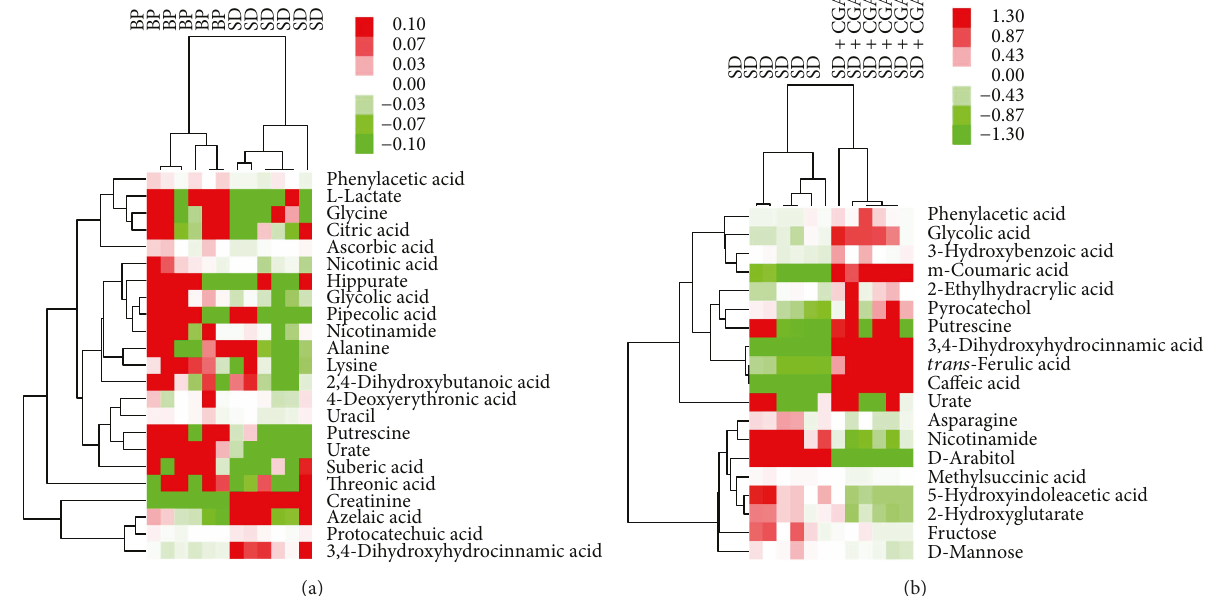
Figure 5: Heat maps described metabolite di ff erence between pairwise